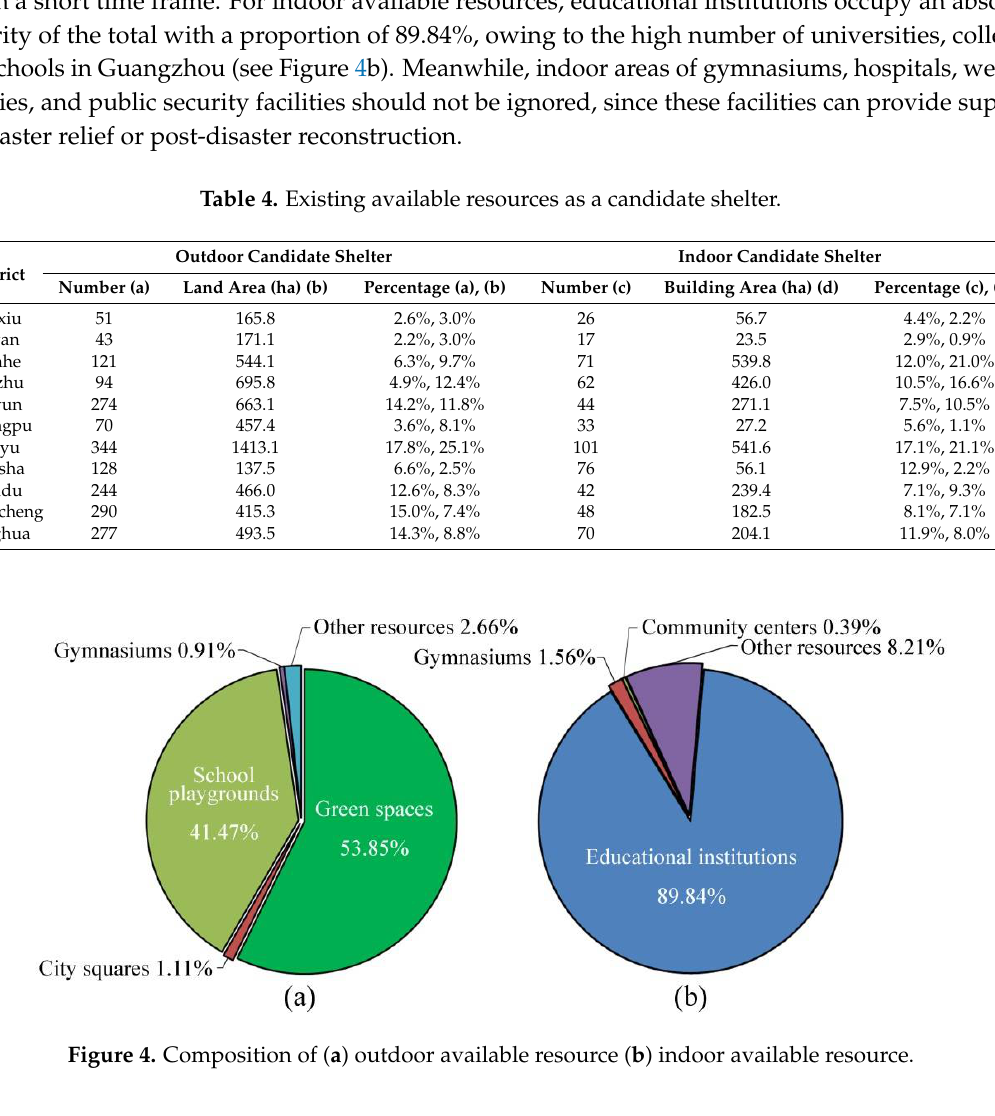
Table 4. Existing available resources as a candidate shelter.